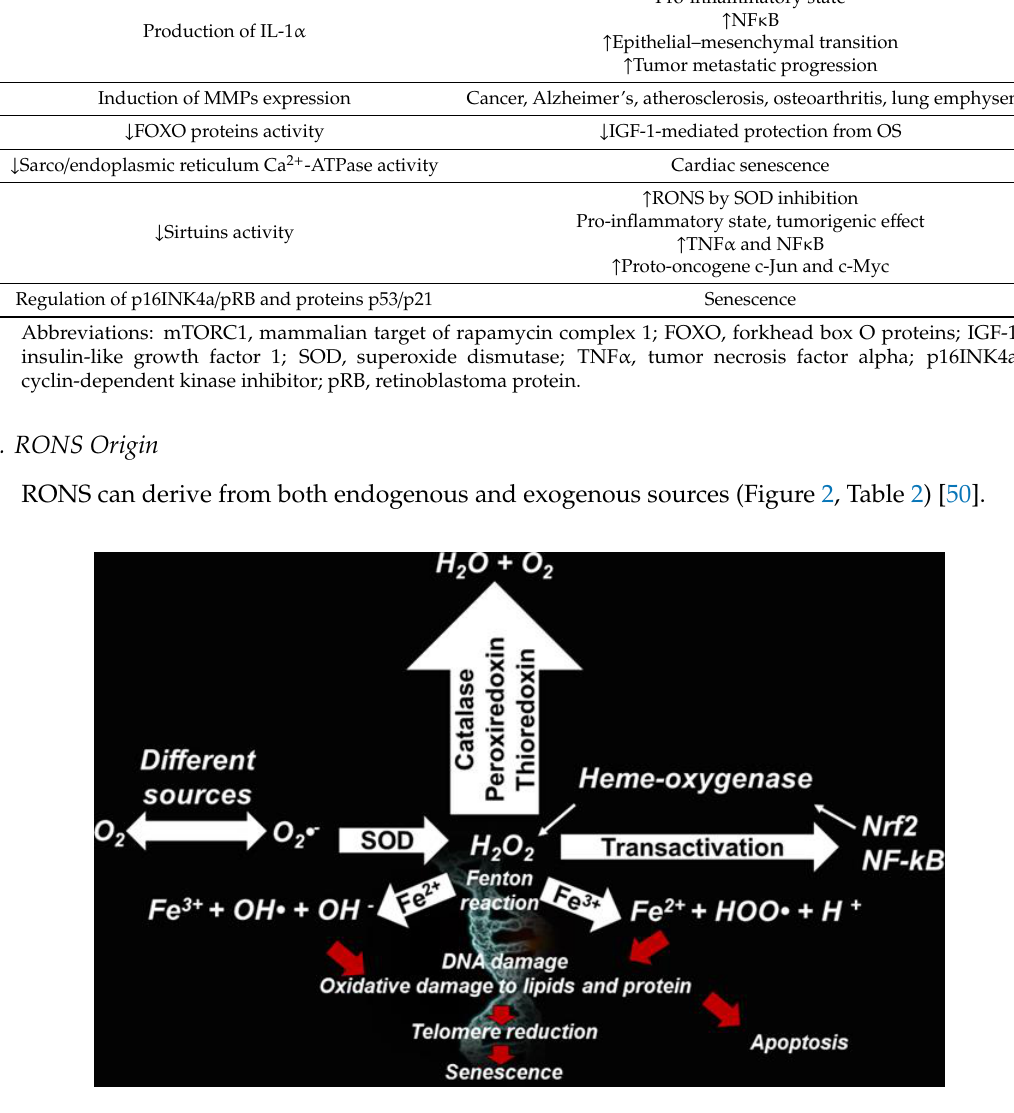
Table 1. Components influenced by reactive oxygen and nitrogen species (RONS) and e ff ects provoked [50]. ↑ Means increase; ↓ means decrease / reduction.